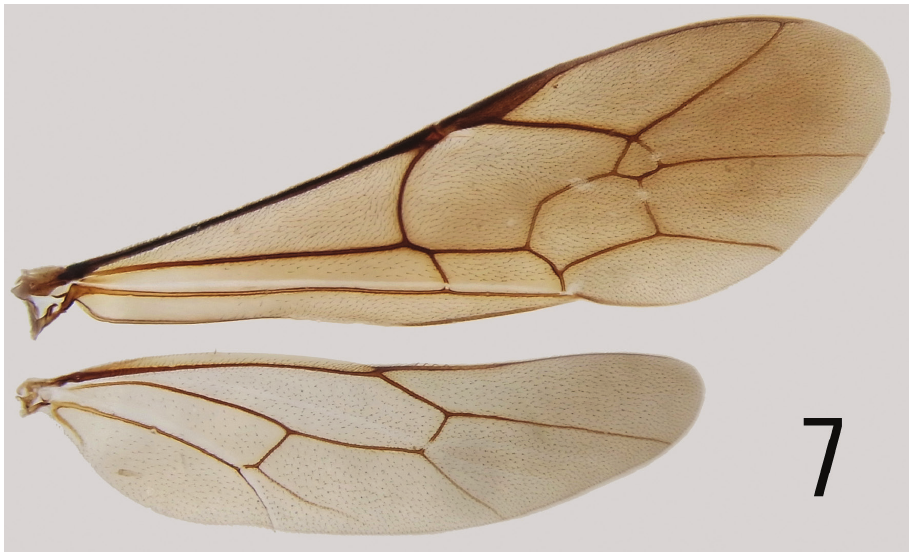
Figure 7. Fore and hind wings of C. sulawesiensis sp. n.